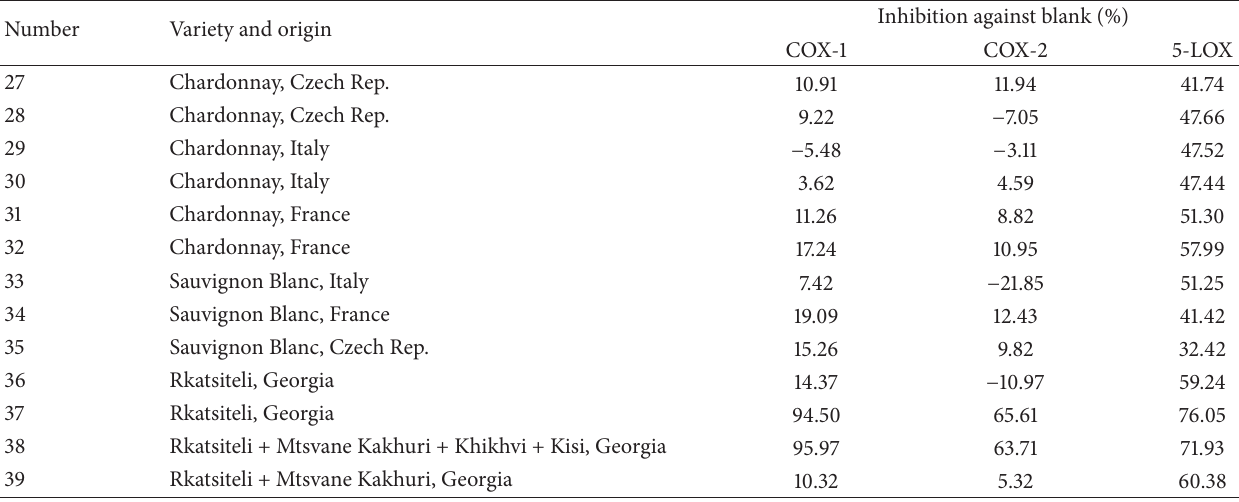
Table 2: Inhibition of COX-1, COX-2 (concentration of wine: 50 mL/L), and 5-LOX (concentration of wine: 18.87 mL/L) enzymatic activity by white